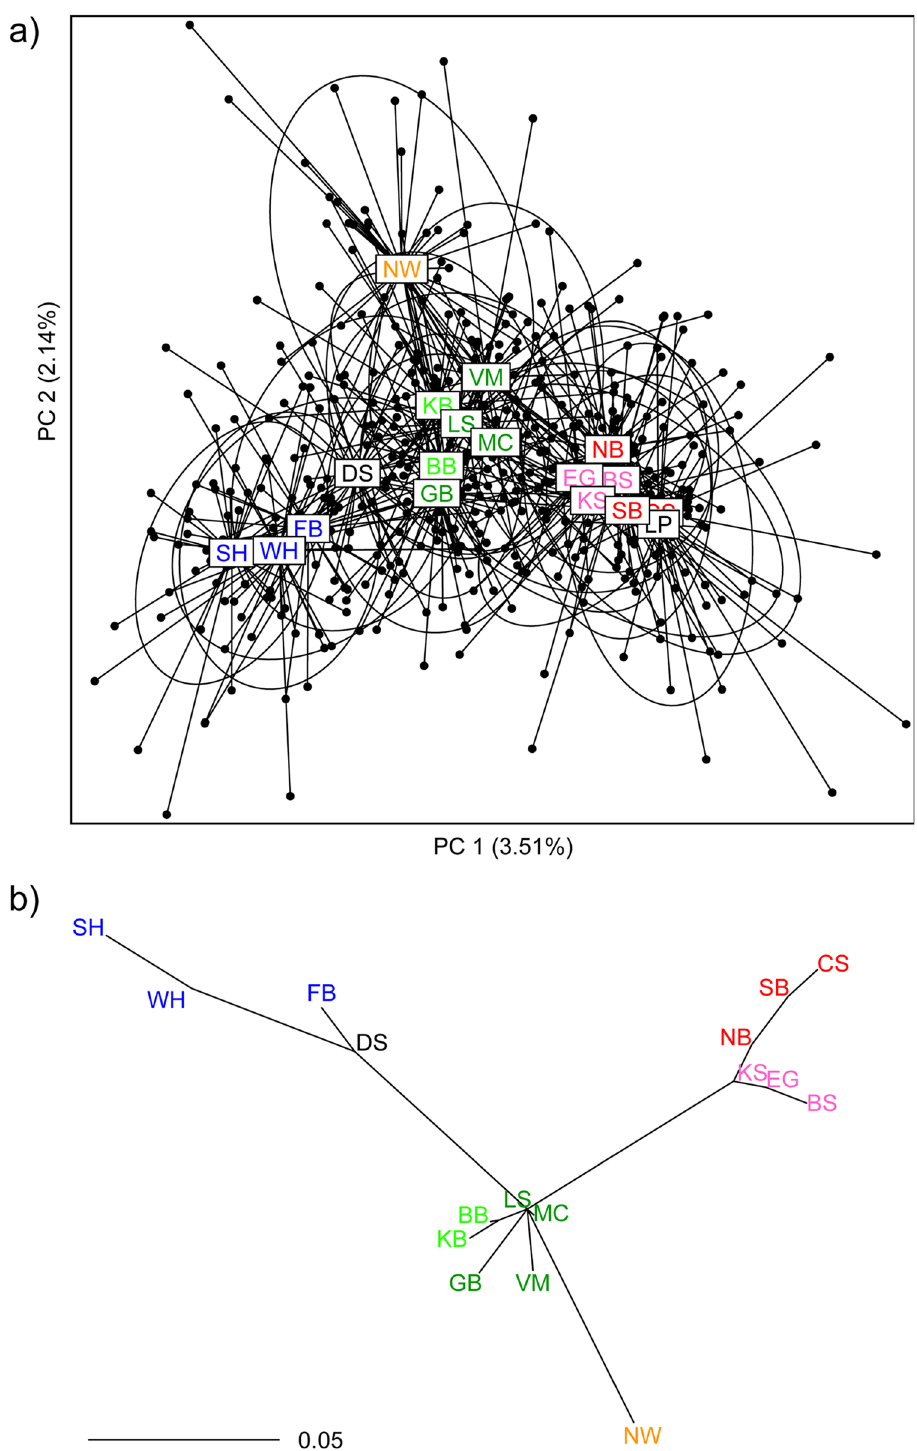
Fig 5. (a) Principal component analysis of genetic variation. Each point represents an individual; each individual is connected to a label indicating the centroid of the management unit in which it was sampled. The inertia ellipse for each management unit contains approximately two-thirds of all individuals sampled there. (b) Population tree. The scale bar indicates Nei ’ s standard distance; branch lengths were estimated using non-negative least squares, and the tree has an R 2 [79] of 0.903. Samples from the Laptev Sea (LP)